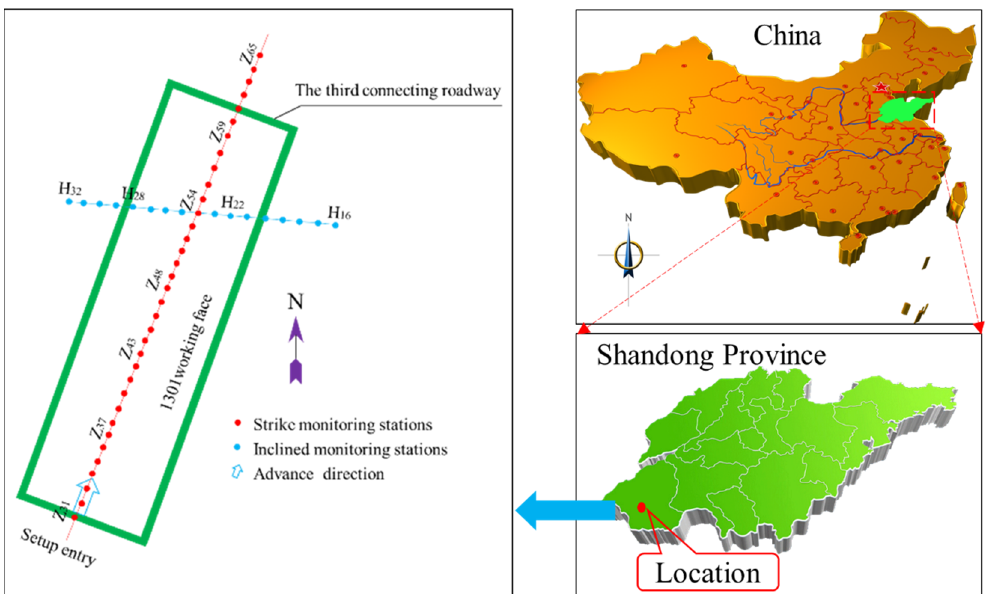
Figure 7. Schematic diagram of the Guotun coalmine location and layout of surface subsidence observation stations above 1301 working face. Table 1. Surface subsidence monitoring data of z38, z41, z44, and z47.